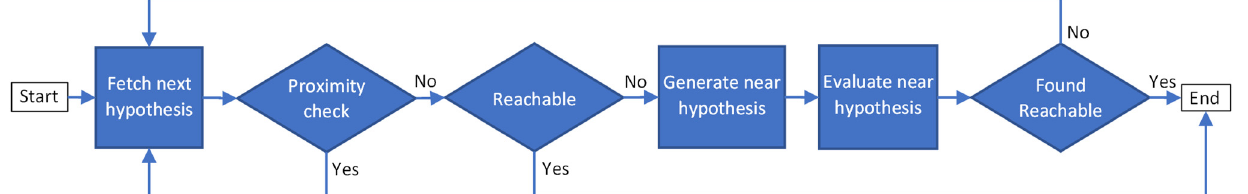
Figure 12. A flow chart of recording position estimation stage. The input hypothesis from the sorted list are analyzed from the highest rated to the lowest, and the first one that is reachable (or produces a nearby pose that is reachable) is used as the next recording position.